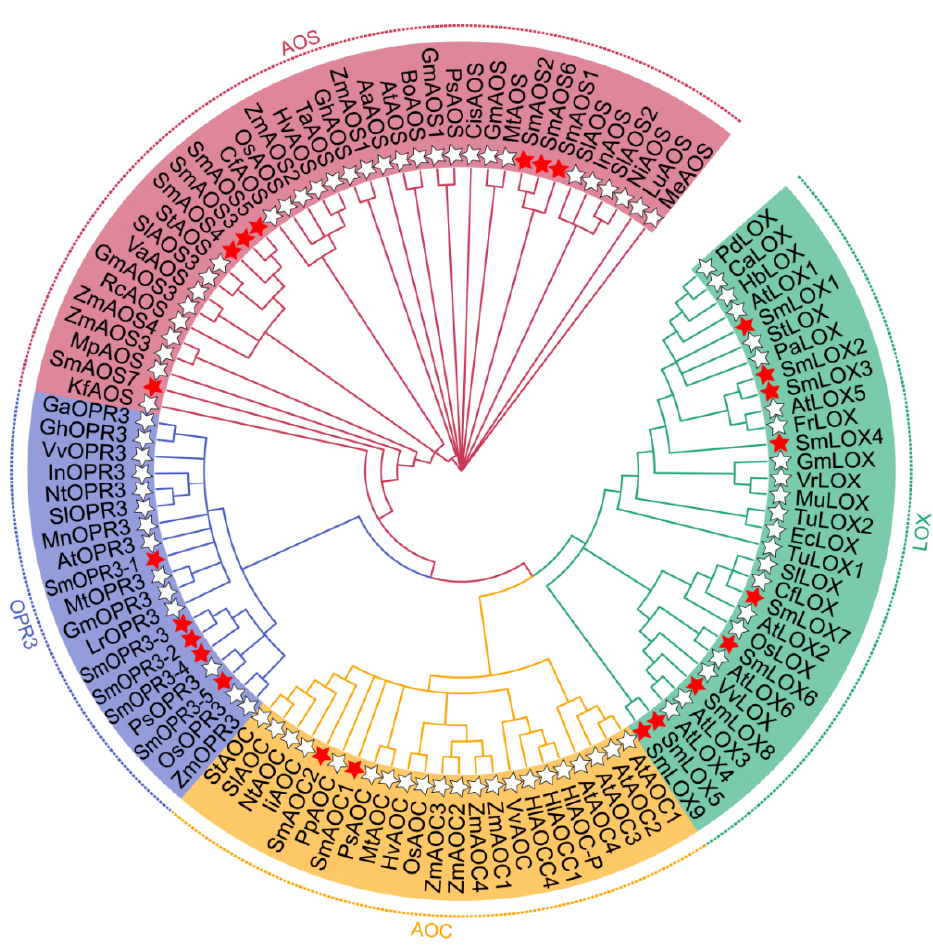
Figure 2. Phylogenetic relationships of JA synthesis pathway enzyme proteins. Amino acid sequences of different plant species were obtained from NCBI based on the accession numbers listed in Table S5. Red five-pointed stars indicate S. miltiorrhiza , and white five-pointed stars indicate other species. The SmLOX expression patterns were different between the roots, stems, leaves,